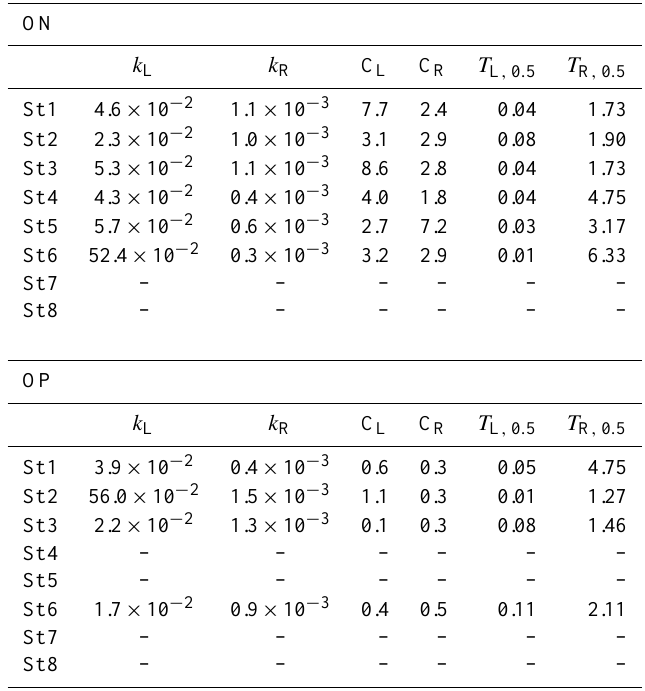
Table 4. Double exponential regression statistics for the temporal trends of total ON and OP degradation in jar experiments. Total organic N (ON) and P (OP) degradation were fitted to the exponential decay function y = C L × exp( − k L × x ) + C R × exp( − k R × x ), where C L and C R denote constants and k L and k R denote decay constants for labile and refractory organic ON and OP, respectively. Statistics were not calculated for St 7–8 (ON) and for St 4–5 and 7–8 (OP), since the temporal degradation patterns did not fit the double exponential decay model. T L , 0 . 5 , and T R , 0 . 5 , denote the half-life ( y ) of labile and refractory ON and OP, respectively. ON k L k R C L C